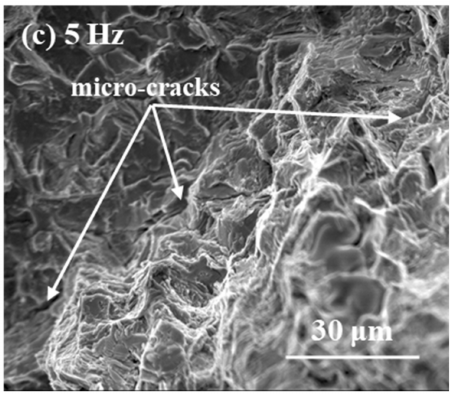
Figure 13. Scanning electron microscope (SEM) fractographs of impact specimens.